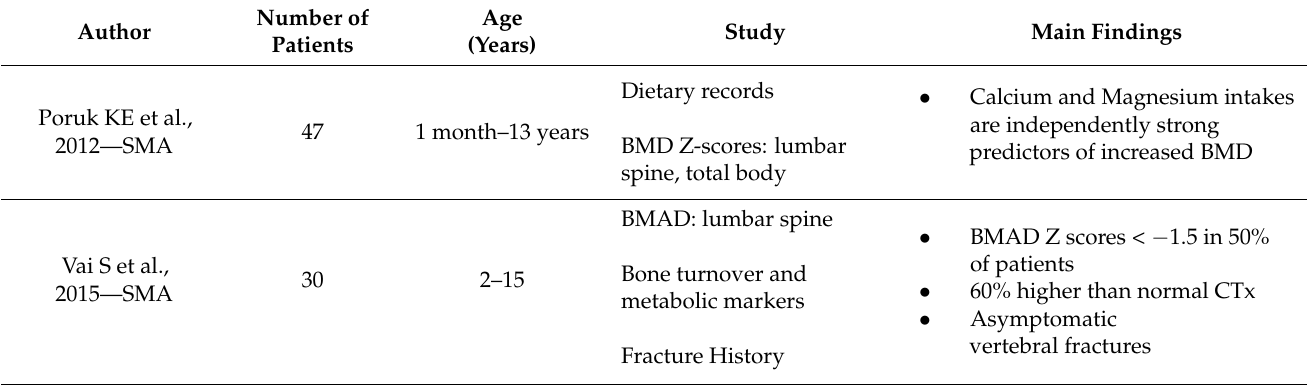
Table 2. Studies evaluating bone quality in patients with Spinal Muscular